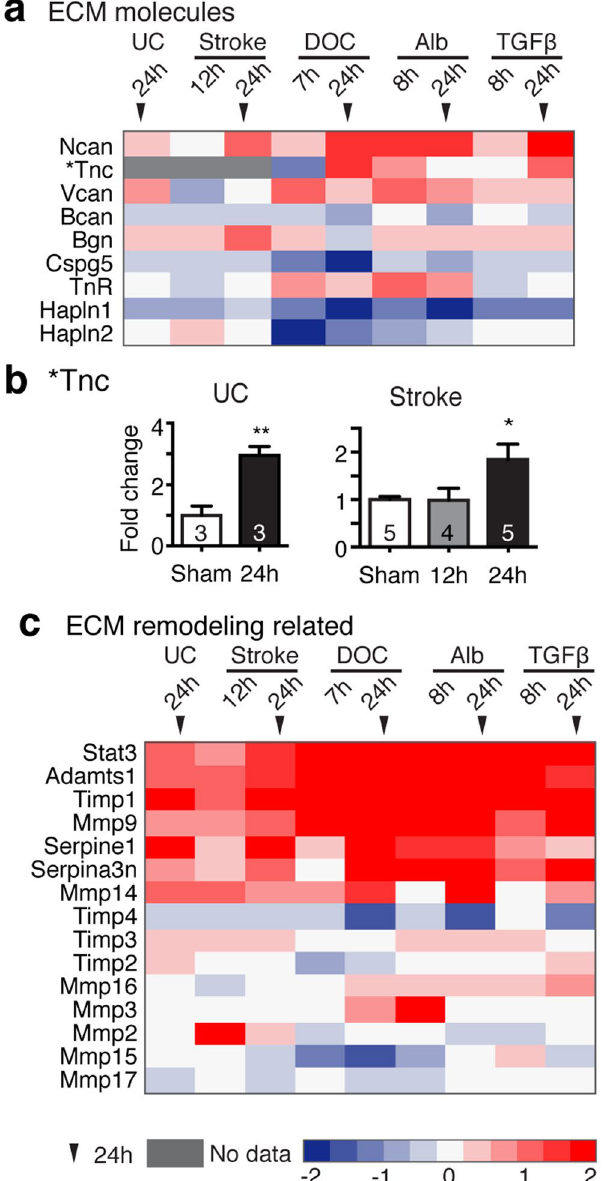
Figure 2. Transcriptional activation of TGF β -regulated extracellular matrix genes across models. The expression levels of genes encoding for extracellular matrix (ECM) components ( a ) and for molecules involved in ECM remodeling ( c ) are shown across models. Heat maps are based on a log 2 scale. ( b ) Quantitative real- time PCR was used to measure mRNA level of Tnc in the undercut (UC) cortex and peri-infarct hippocampi (Stroke). One way ANOVA with posthoc Turkey’s test (in Stroke, B) and student t-test (in UC). The number of animals used per condition is indicated within the